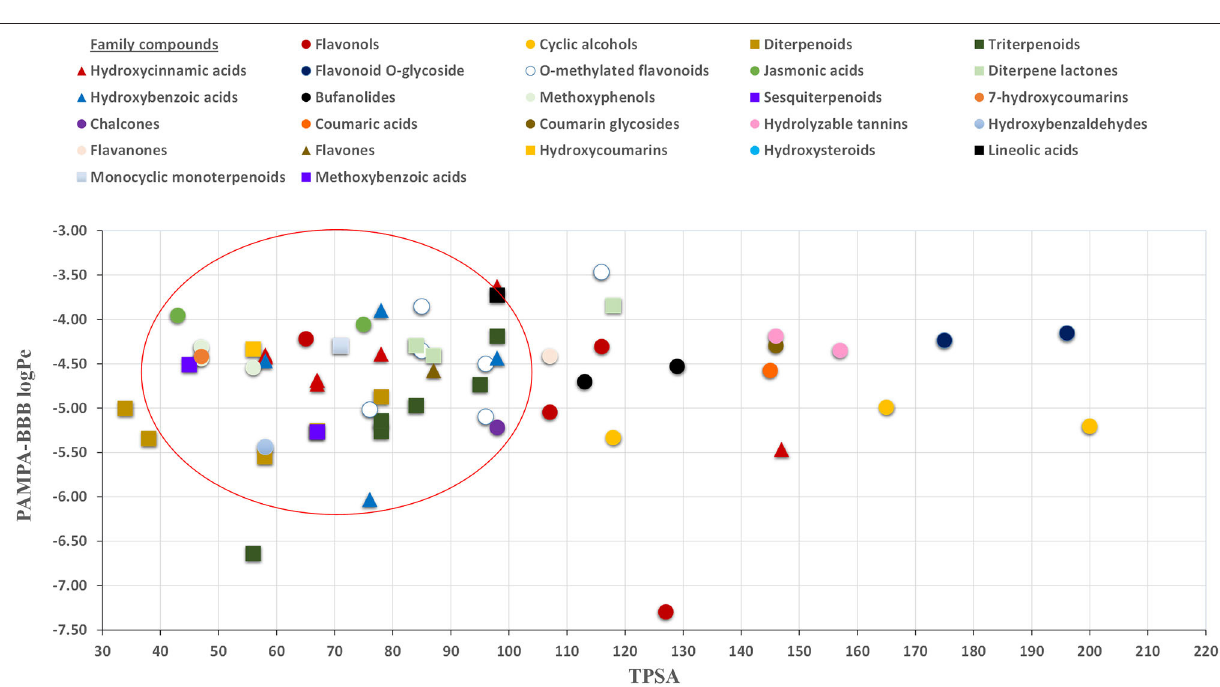
authors did not find evidence for the relationship between phenolic compounds and toxicity in SH-SY5Y cells, and phenolic